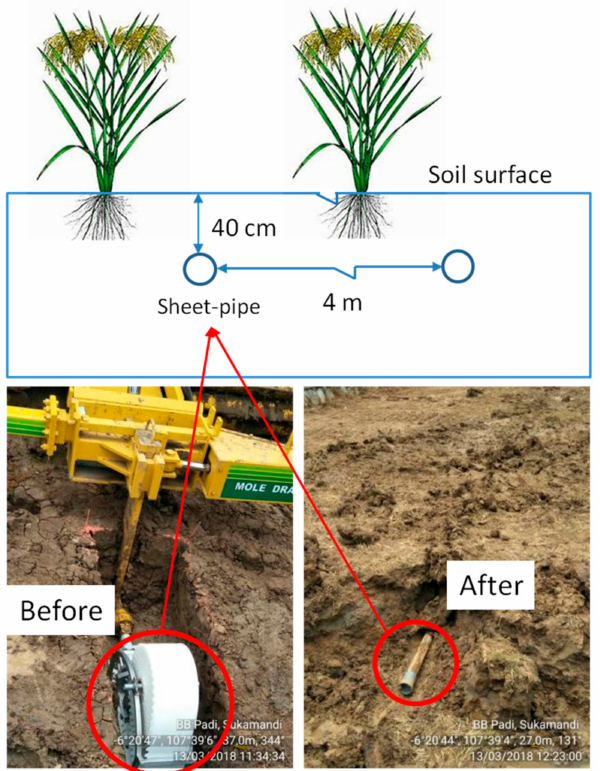
Figure 2. Sheet-pipe installation in the field.